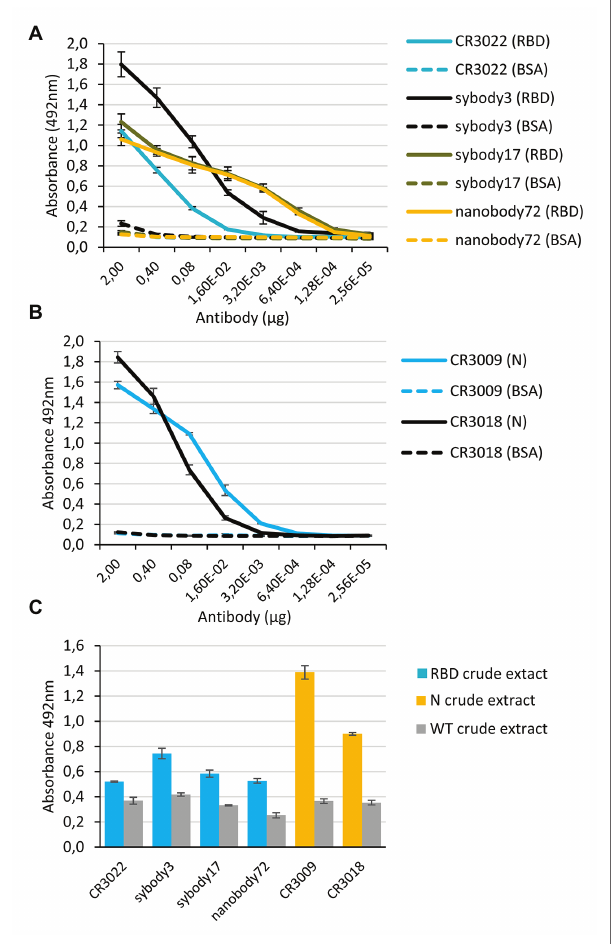
FIGURE 4 | Comparison of binding activities of anti-SARS-CoV-2 purified antibodies by ELISA tests. (A,B) Antigen ELISA titers graph of anti-RBD (A) or anti-N (B) purified antibody preparations. Binding activities were calculated by absorbance measurements at 492 nm. The X axis indicates the amount ( μ g) of antibody preparation per well. Solid lines indicate the ELISA test against RBD commercial or our purified His:bN protein, and dashed lines indicate the corresponding control ELISA tests against BSA. Bars represent mean ± SD, n = 3 independent replicates. (C) Sandwich ELISA plots obtained using anti- RBD and anti-N purified antibody preparations (1 μ g per well). Plates were coated with commercial anti_His monoclonal antibody, incubated with crude extracts of plant-made antigens (nRBD:His or His:bN, respectively), and developed with the different plant-made antibody preparations as indicated. Wild type crude extracts samples were used as negative control. Bars represent mean ± SD, n = 3 independent